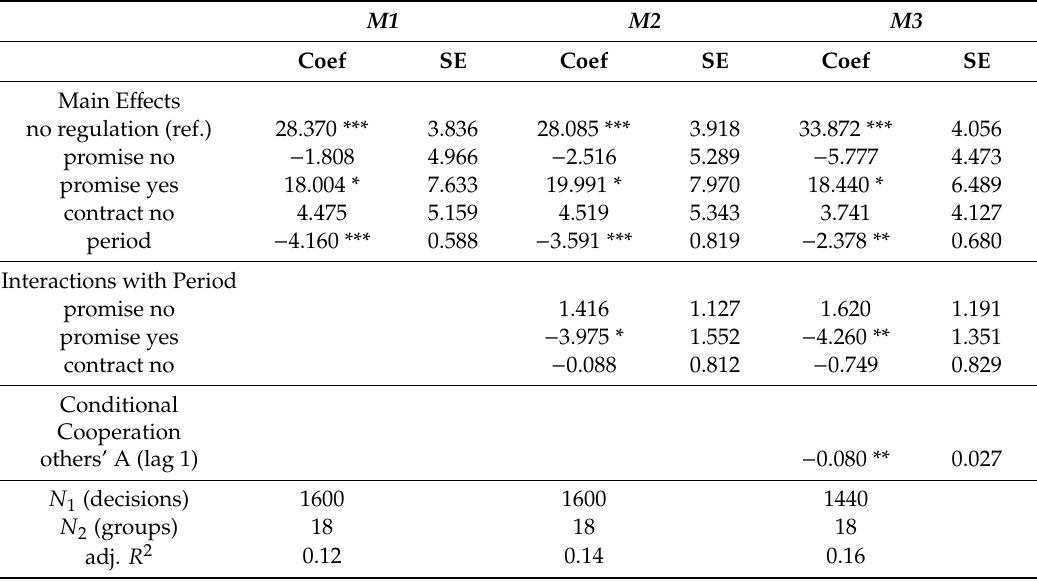
Table 1. Determinants of subjects’ investment in Asset B.